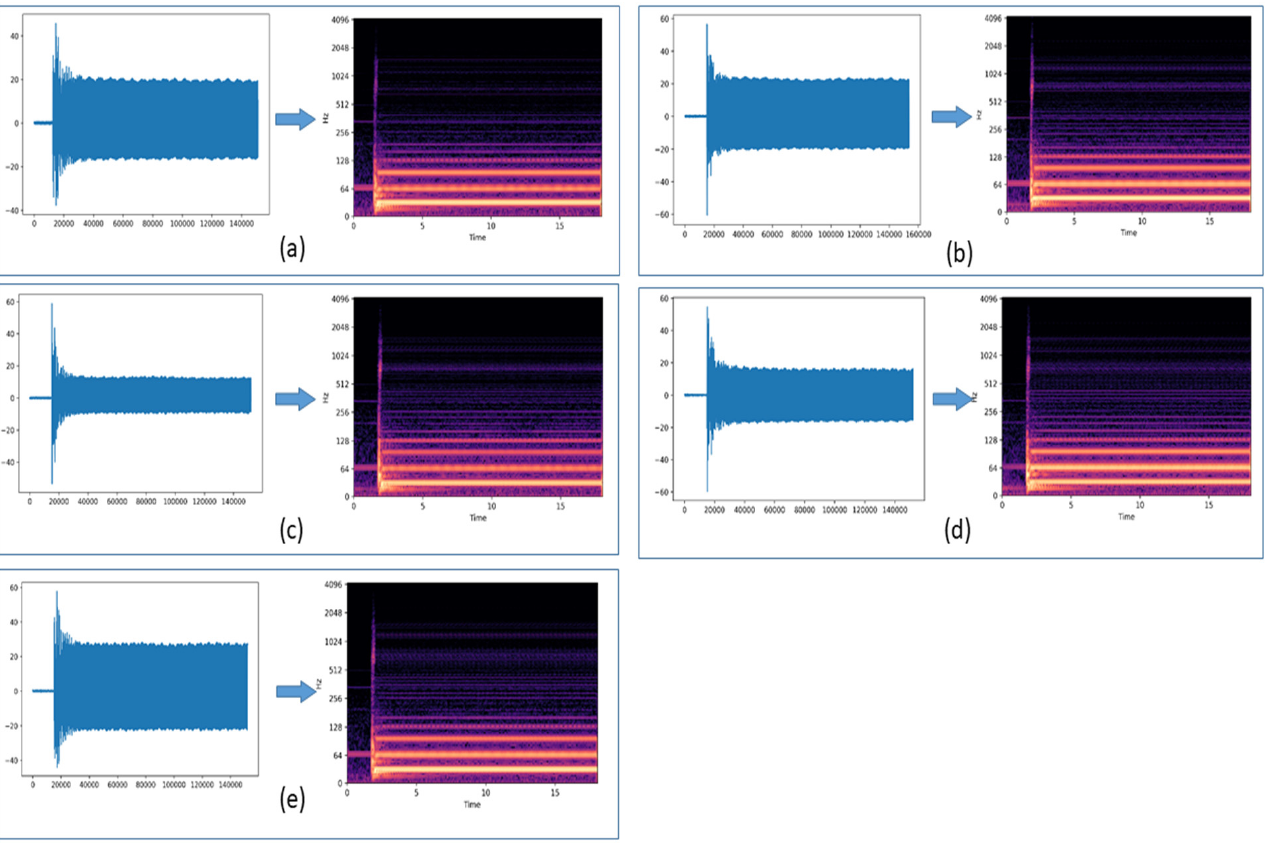
Figure 7. The STFT data plotted and the generated spectrogram of the vibration data for 2.5 Nm torque condition ( a ) healthy rotor ( b ) one broken rotor bar ( c ) two broken rotor bars ( d ) three broken rotor bars ( e ) four broken rotor bar.